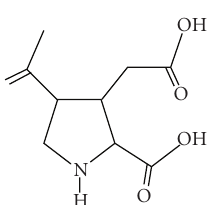
Figure 1: The molecular structure of kainic acid (2-carboxy-4- isopropenylpyrrolidin-3-ylacetic acid, KA). The molecular formula of KA are C 10 H 15 NO 4 and the molar mass of KA is 213.23 g/mol.